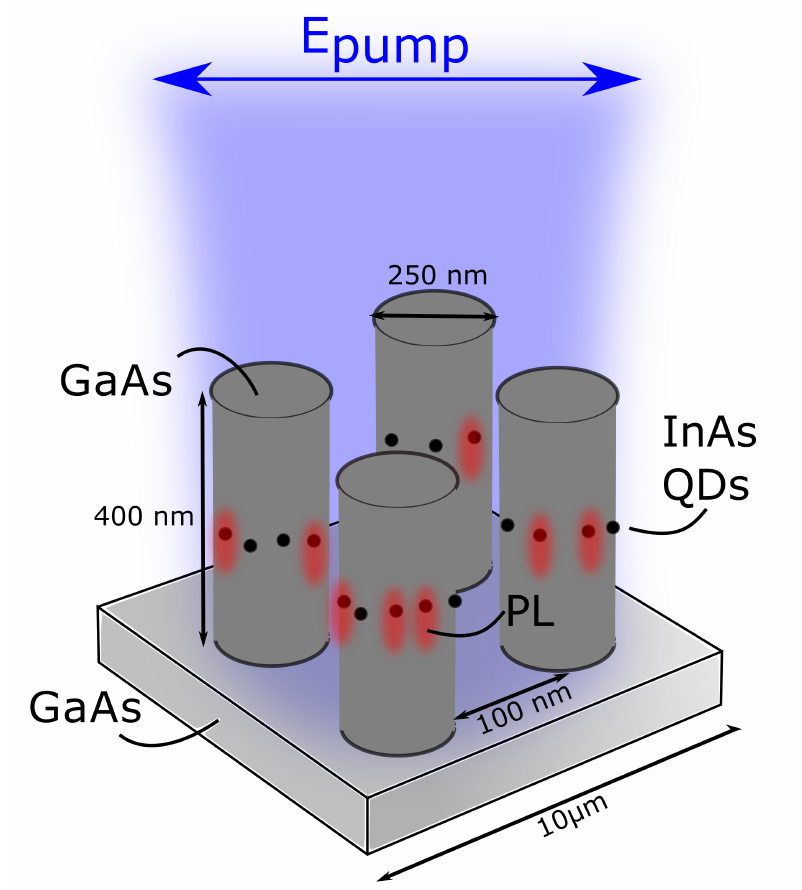
Figure 1. Schematic representation of PL enhancement in InAs QDs embedded into the GaAs